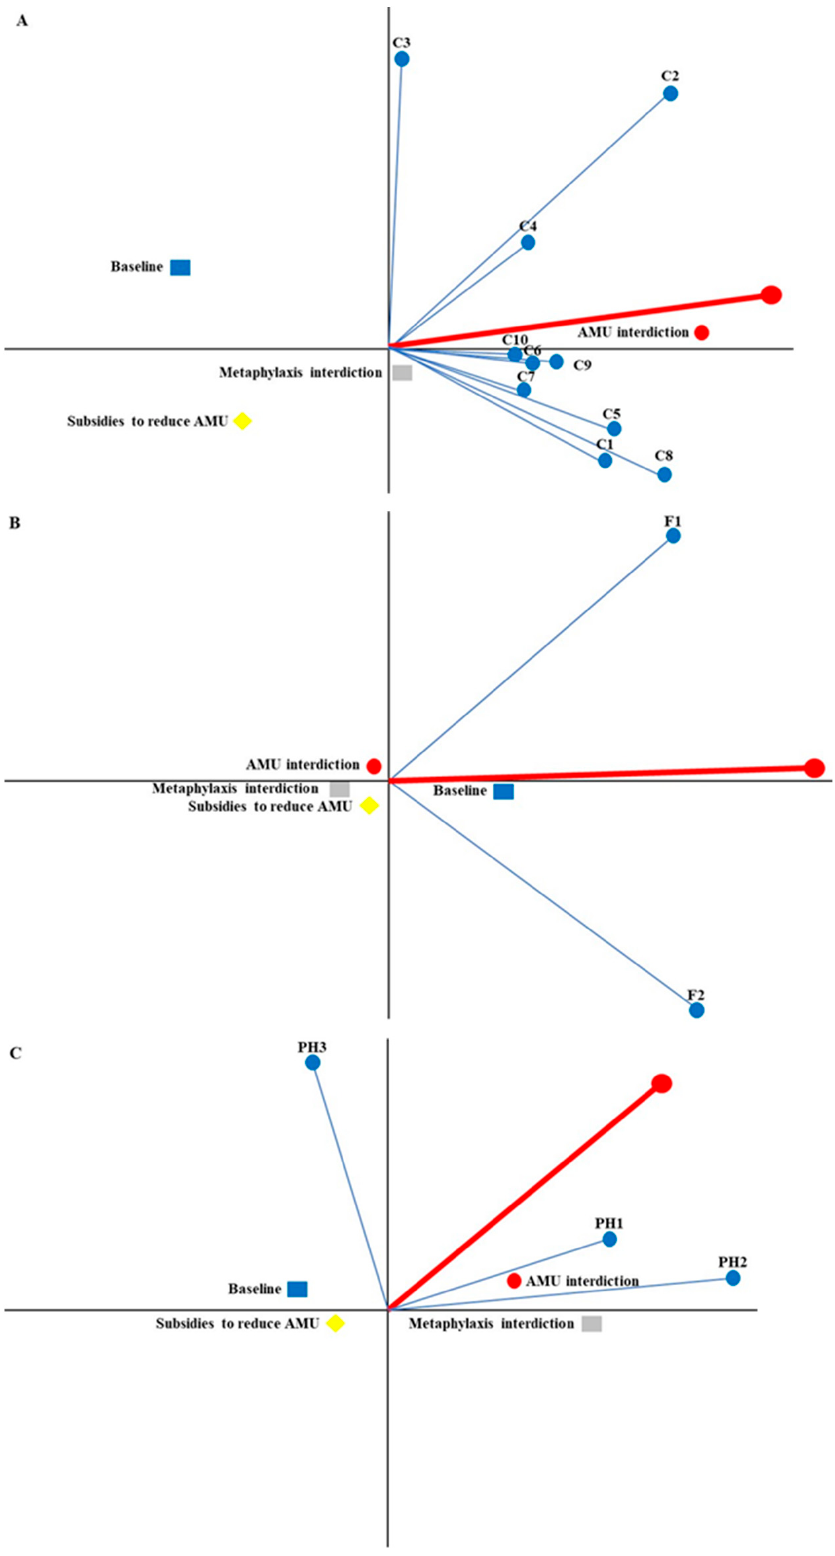
Figure 1. Decision map (GAIA plane) of consumers ( A ), farmers ( B ), and public health ( C ) decision makers weighted preferences. (Delta = 96.6%; 96.6% of the information is conserved in the two-dimensional representation of this map).